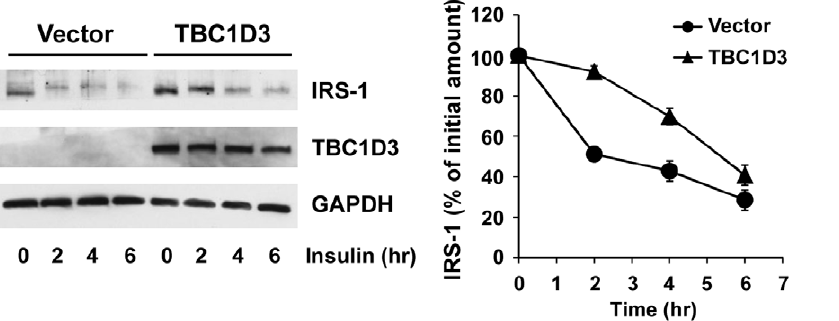
Figure 3. TBC1D3 expression blocks IRS-1 degradation. IRS-1 degradation is delayed in cells expressing TBC1D3. DU145 cells transfected with myc-TBC1D3 or empty vector were serum-starved, and stimulated with insulin (10 nM) for the indicated times. Protein levels of IRS-1 were analyzed by Western blotting. ( Right panel ) Quantification data of IRS-1 normalized to GAPDH protein levels. The value of IRS-1 at time 0 was set at 1.0. The data are presented as means 6 SD of three independent experiments.